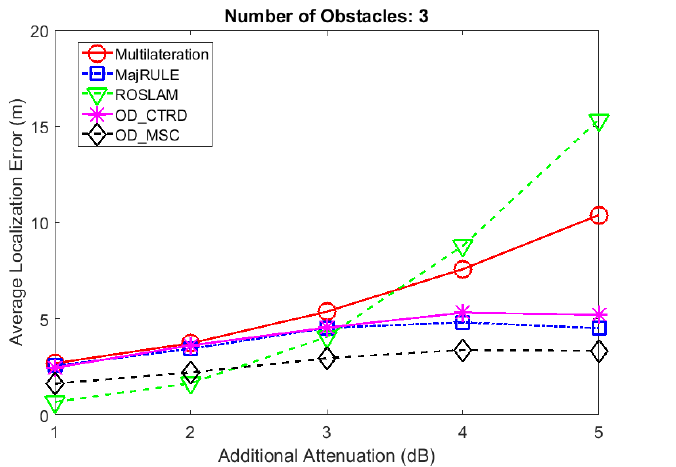
Figure 13. Comparison of the localization accuracy using varying added attenuation of 1 dB to 5 dB.